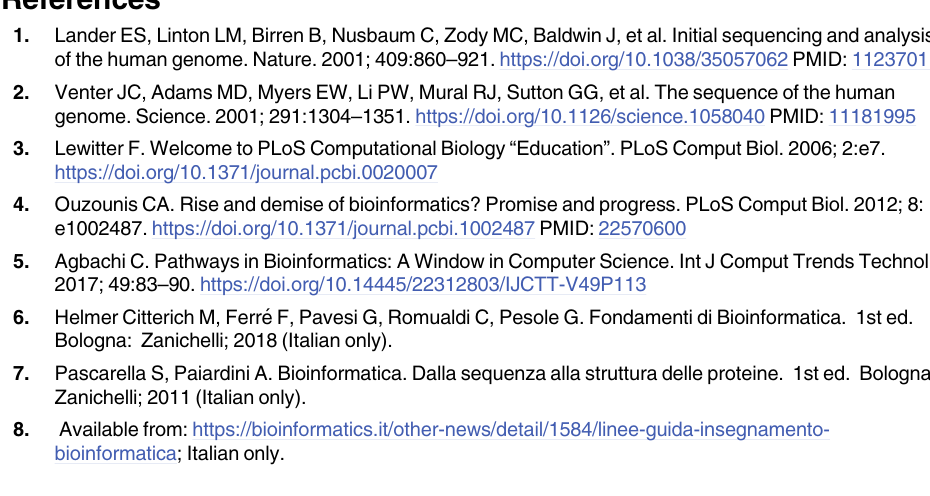
S3 Fig. Frequency of the topics treated in the bioinformatics courses. Since multiple answers were allowed in the survey, the total is higher than